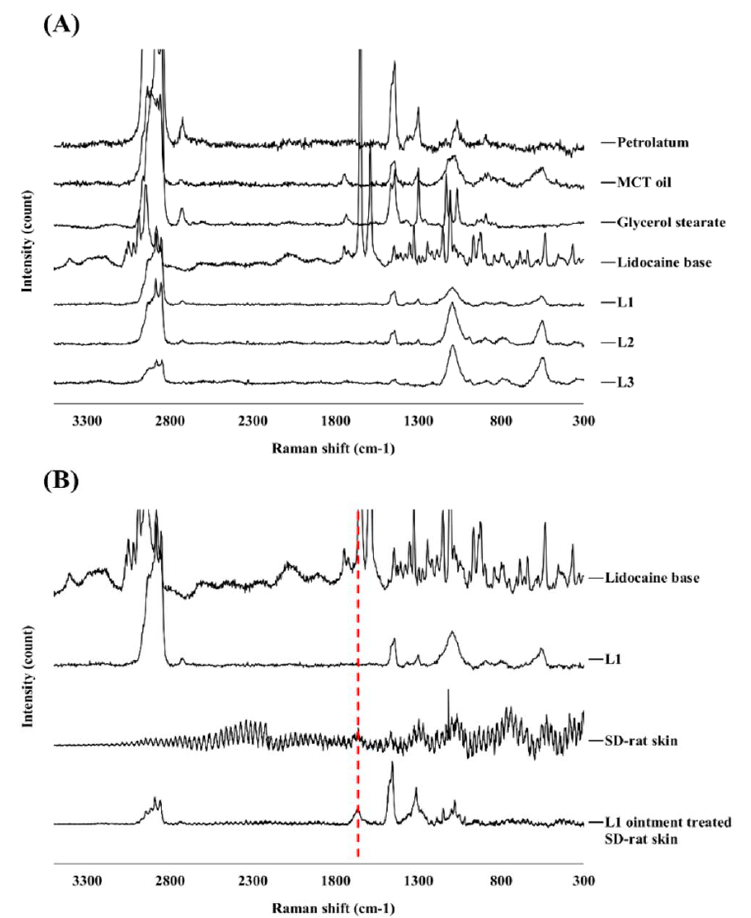
Figure 2. X-ray diffraction patterns of raw materials and prepared lidocaine ointments. MCT, medium-chain triglyceride.